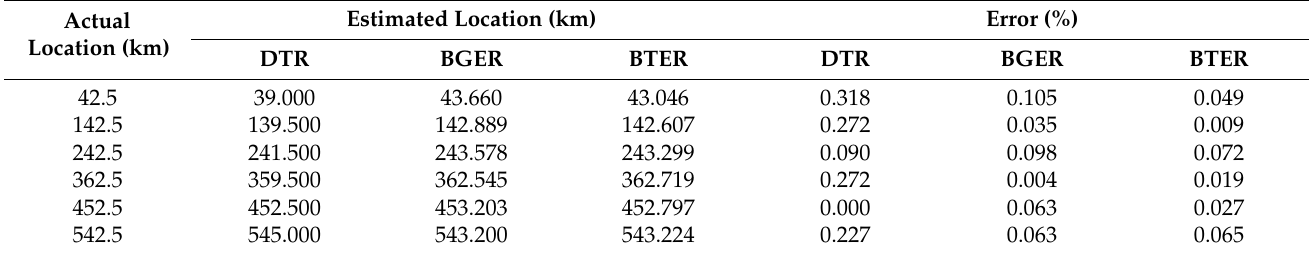
Table 6. Actual and estimated fault location for double pole to ground fault.